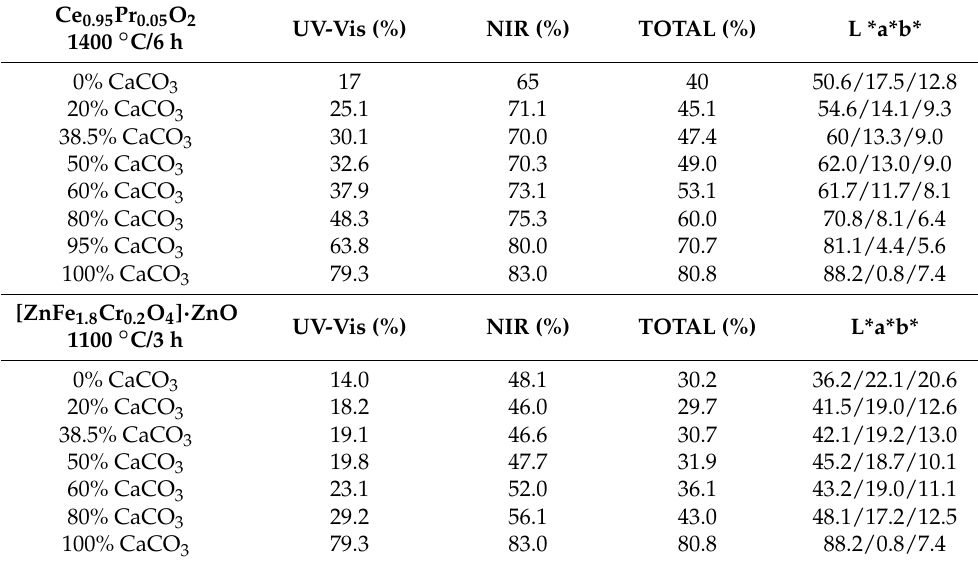
Figure 7. R NIR versus lightness L* of blue pigments with gradual addition of the binder CaCO 3 . (b) In the case of red-brown pigments, the chroma C* is higher for Cr-franklinite (C* = 30.2 vs. 21.7 for Pr-cerianite), being this value is closer to its absolute value of a*. The L* value is higher for Pr-cerianite (50.6 vs. 36.2 for Cr-franklinite) and shows higher R NIR (65% vs. 48% for Cr-franklinite). The evolution of colorimetry and reflectance data with the gradual addition of CaCO 3 binder to the pigments are shown in Table 3 and the representation of R NIR versus lightness L* follows a linear relationship in Figure 8. The R NIR 55 (reflectance associated to a L* = 55, considered for red hues) is 69% for rare-earth Pr-cerianite pigment and 59% for classical Cr-franklinite spinel pigment. Therefore red-brown Pr-cerianite powder shows better performance as a cool pigment. Table 3. Colorimetry and reflectance parameters for CaCO 3 addition to red-brown pigments.